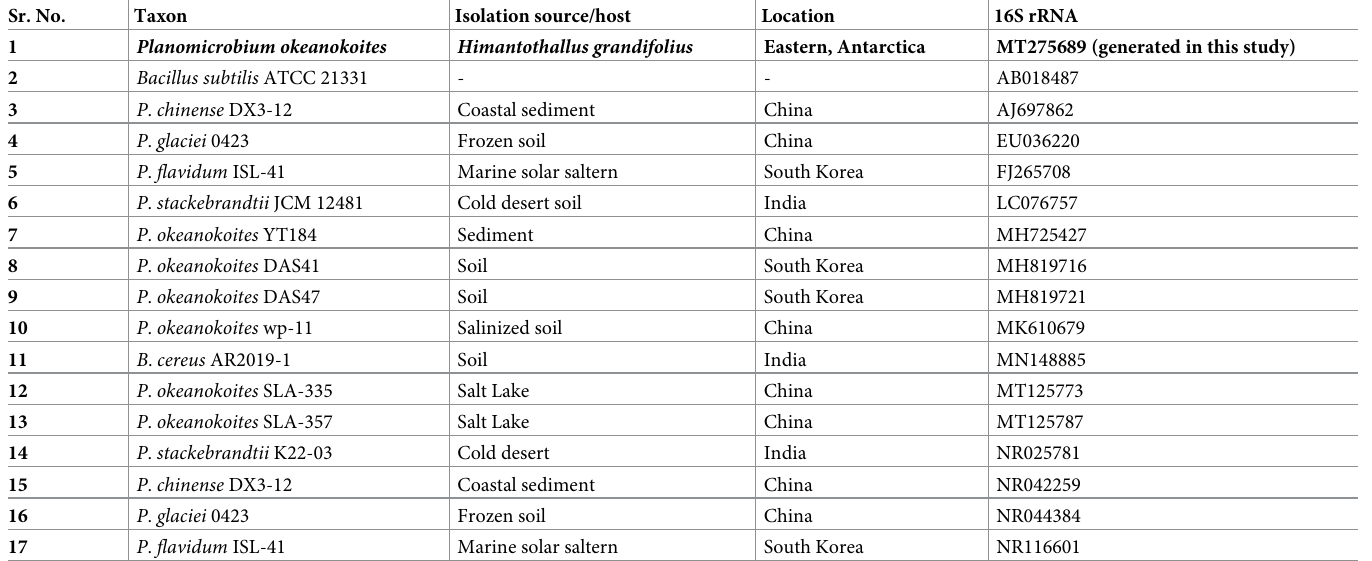
Table 3. Accession numbers of 16S rRNA sequences procured from the NCBI database. Sr.